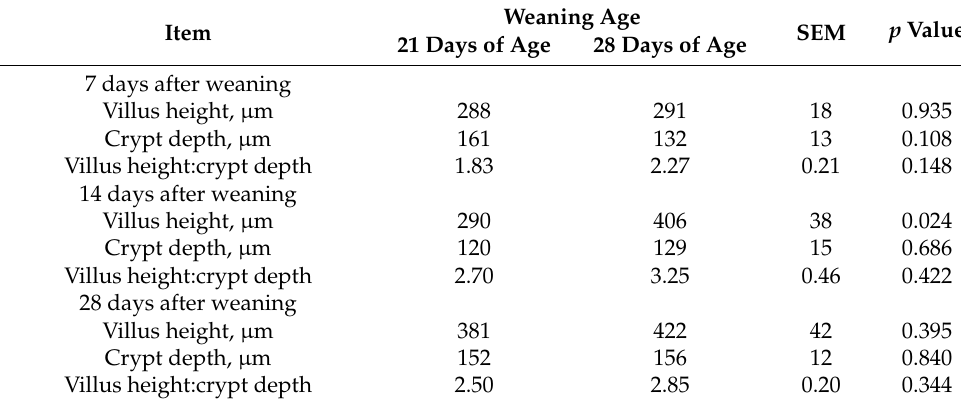
Table 7. Effect of weaning age on morphology of ileum in weaned pigs 1 .